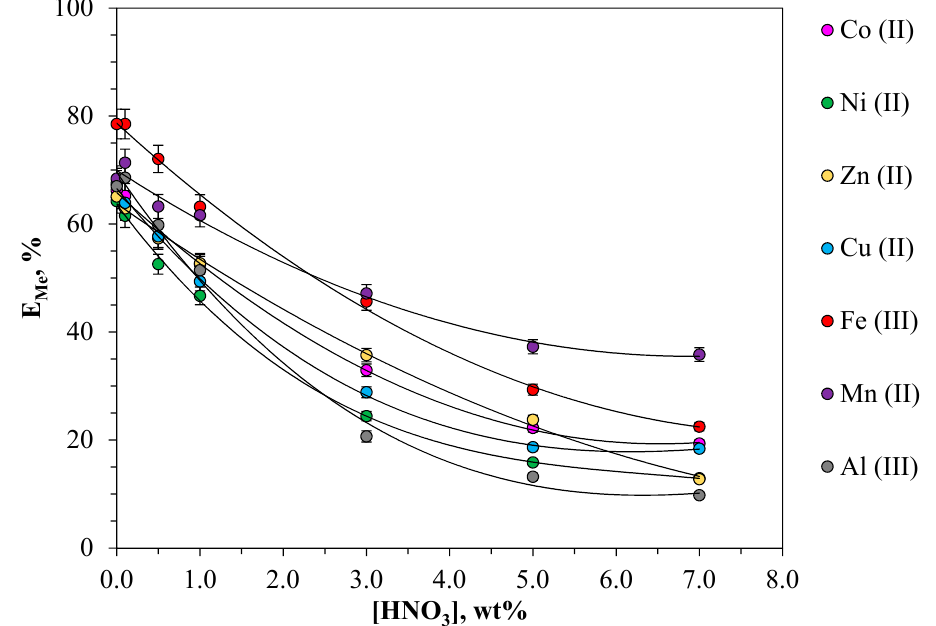
Figure 3. Effect of nitric acid on the metal extraction in the PEO 1500-NaNO 3 -H 2 O system: [Me] in = 0.01 mol·L − 1 , temperature: 298.15 K.